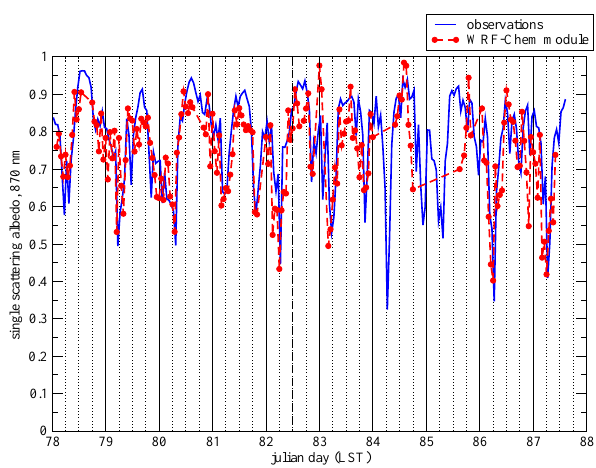
Fig. 6. Same as Fig. 5, except for single scattering albedo.